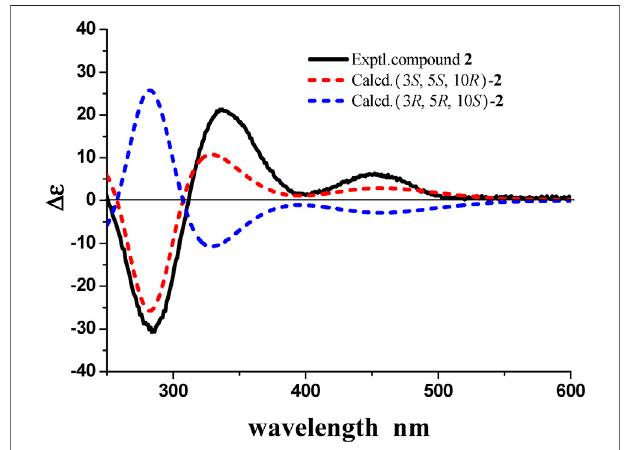
FIGURE 5 | Experimental ECD spectra of 2 and calculated ECD spectra of(3S,5S,10R)-2and(3R,5R,10S)-2(UVcorrection (cid:1) − 24 nm,bandwidth σ (cid:1) 0.3 eV.